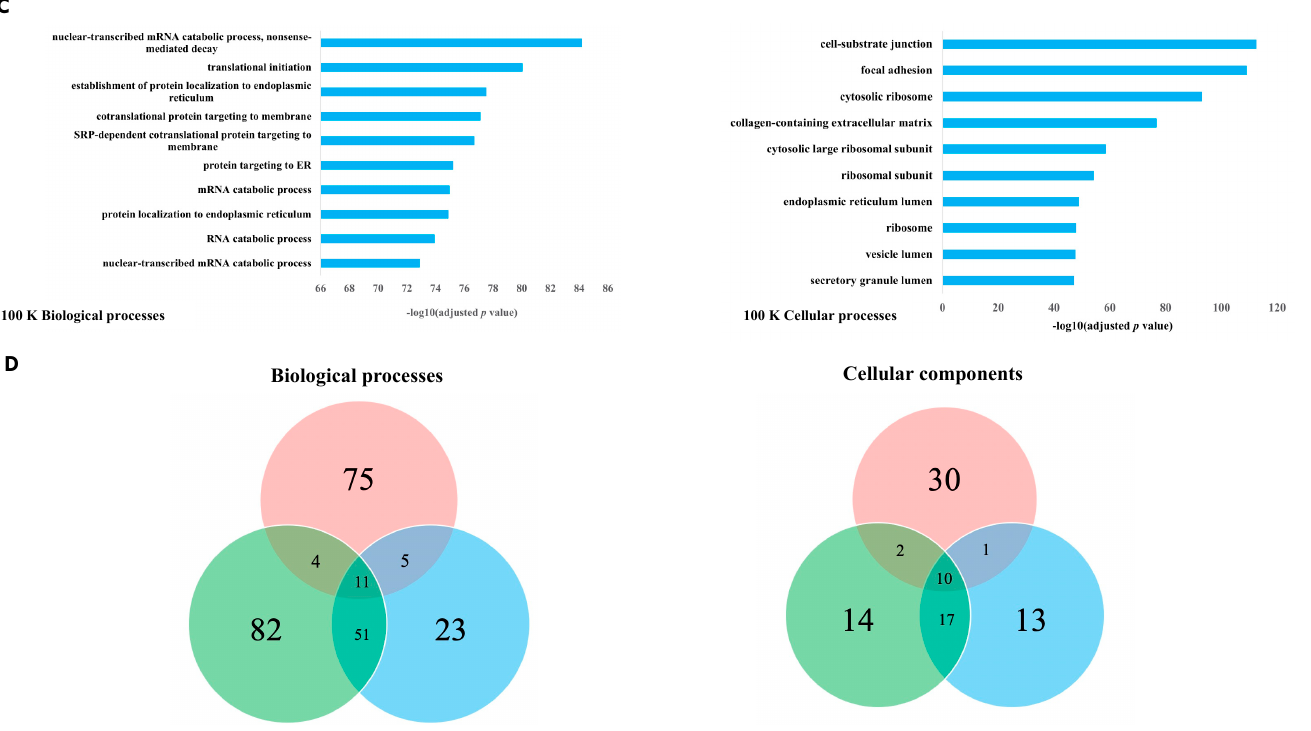
Figure 8. Subcellular location and biological processes of the total identified proteins of each EV subtype derived from mesothelioma cell lines. Top 10 biological processes and enriched cellular components associated with EVs derived from mesothelioma cell lines versus control for ( A ) 10 K EVs, ( B ) 18 K EVs, and ( C ) 100 K EVs. ( D ) Venn diagram showing biological processes and cellular components that are common and unique to each EV pellet from mesothelioma cell lines versus the corresponding control EV pellets. Data obtained from four biological replicates. Table 4. Biological processes exclusive to each EV pellet.